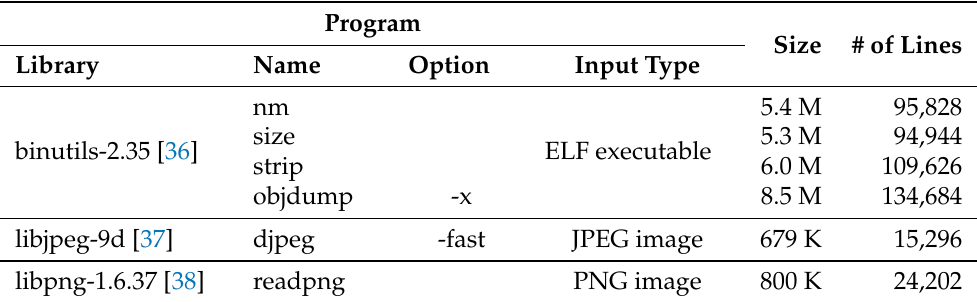
Table 1. Tested programs. Options are command line options to run program. Size column shows the size of binaries in bytes. Number of lines is total lines of user-defined code.